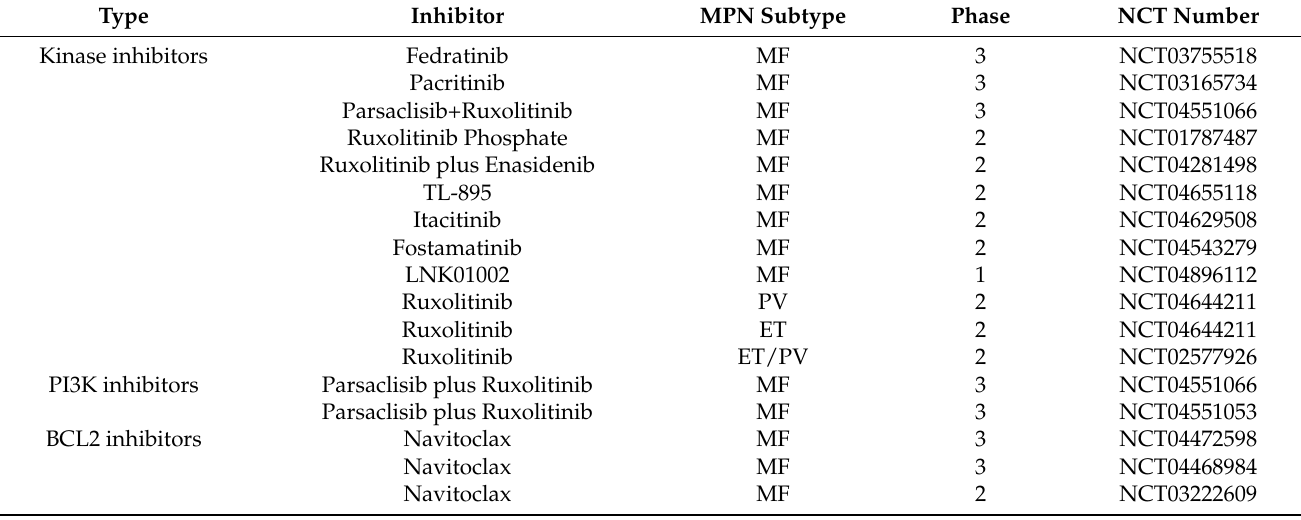
Figure 2. Ongoing clinical trials in MPN. Overview of selected clinical trials in MPN within the respective drug classes (including clinical trial phases and MPN subtype). The ratio of the respective drug class is given in % (relative to the total amount of studies ( n = 49)). Data were obtained from ClinicalTrials.gov, accessed on 10 December 2021. For more information, see Table 2. Table 2. Selected ongoing clinical trials in